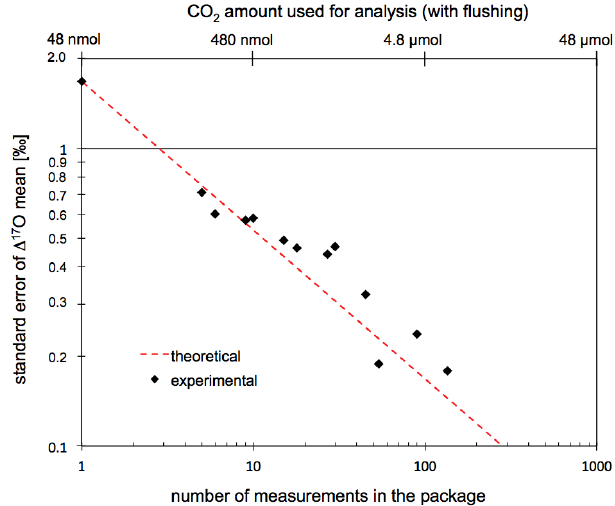
Figure 7. Improvement of the measurement precision by perform- ing multiple measurements on the same air sample. The ln of the standard error (SE) is plotted versus ln of the number of measure- ments ( n ) that were included in the calculation of the SE. The upper axis represents the amount of CO 2 used for analysis including sam- ple loop flushing. A SE of about 0.2‰ can be reached after about 100 measurements. The experimentally derived slope for the error reduction is − 0.468, which is close to theoretical value −